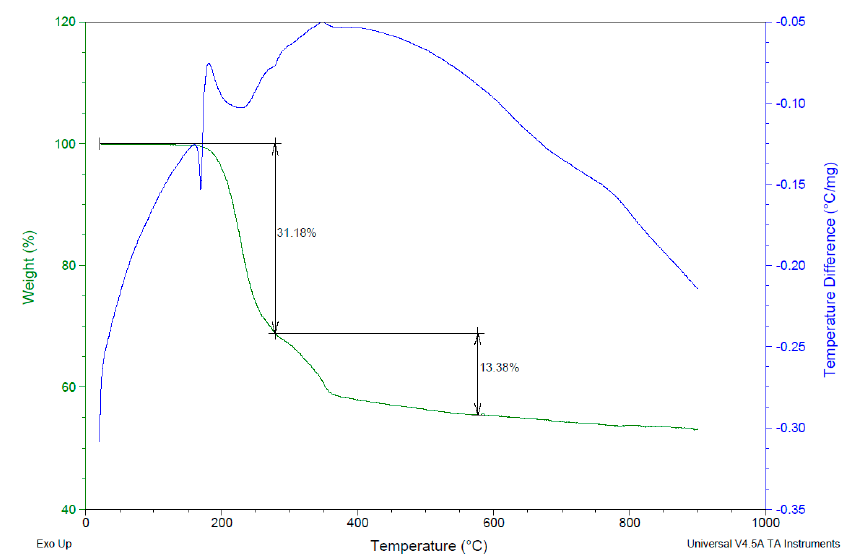
Figure 1. TGA–DTA analysis of the Au(III) trichloride complex 8a